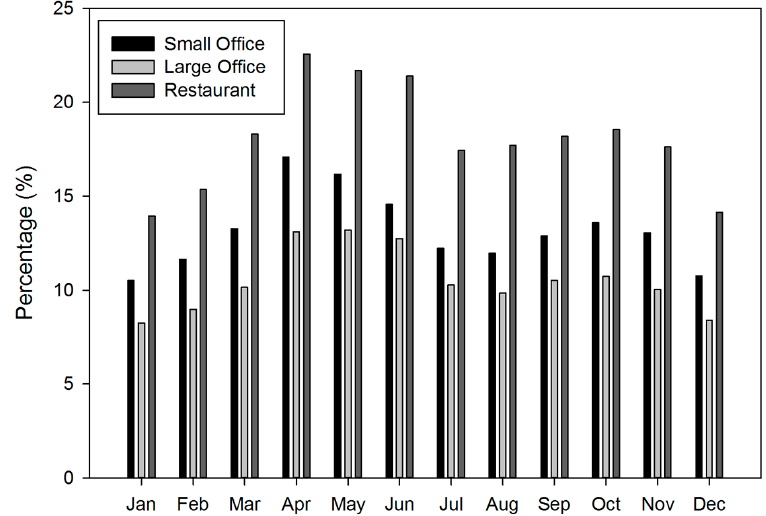
Figure 6. Monthly percentage of CDE savings for each of the modeled buildings.